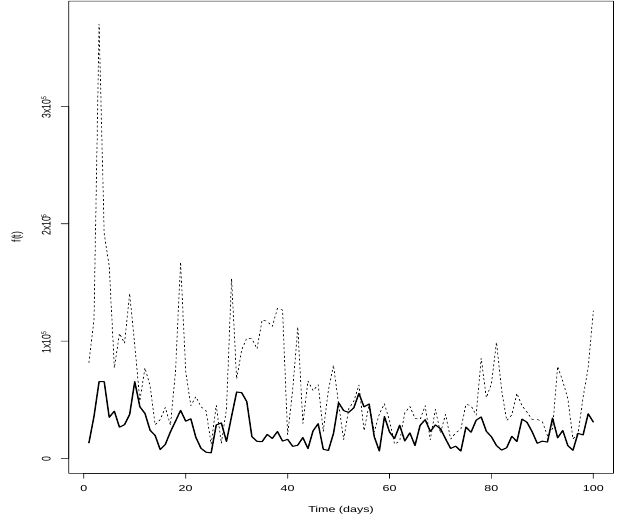
Figure 5. The estimated price functions, f P (bold line) and f W (dotted line), with respect to the first one hundred